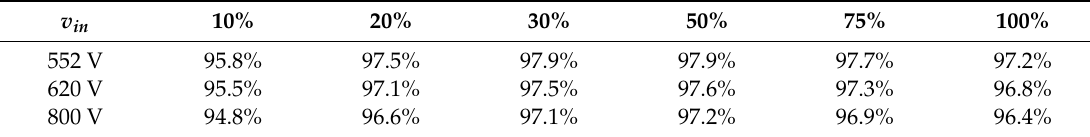
Table 4. Power Electronics FS0900CU e ffi ciency data.